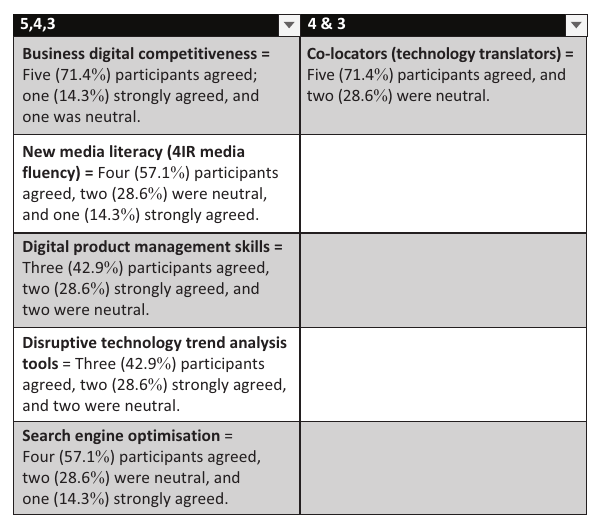
FIGURE 6: Results of digital skills with no consensus.